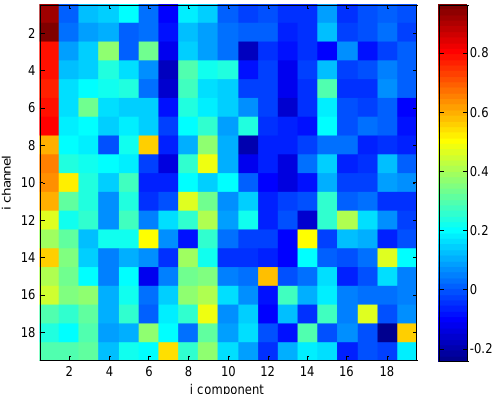
, s ). The first component is blink IC. i j